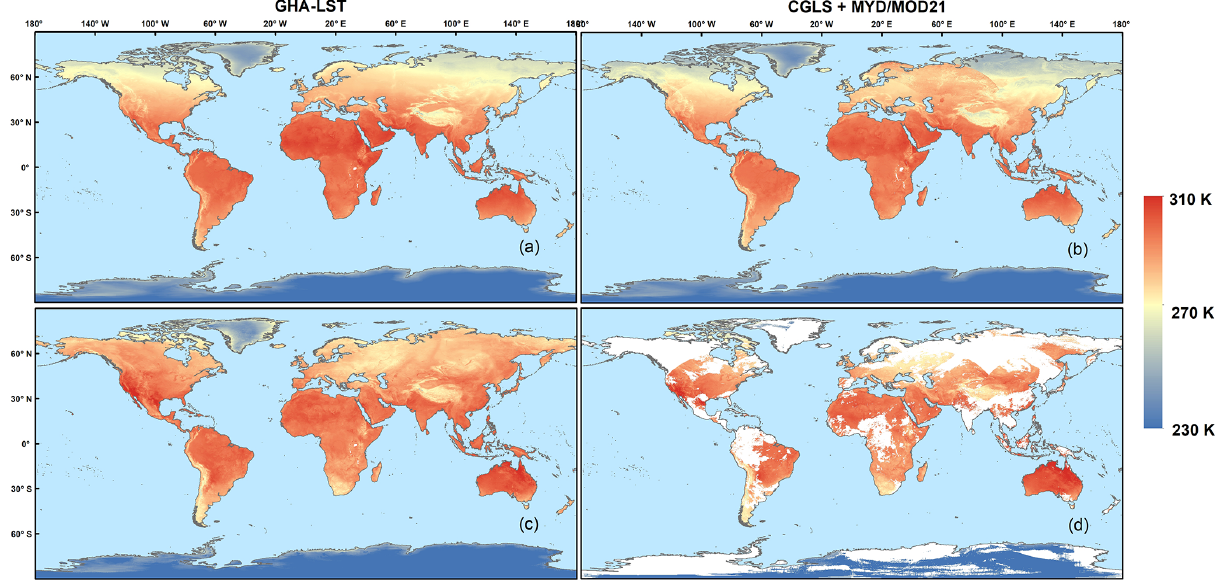
Figure 8. Global LST maps of the (a) GHA-LST annual mean in 2021 and the (b) CGLS, MYD, and MOD21 annual mean in 2021 as well as the corresponding hourly LST maps at 02:00UTC on 7 September 2021 for (c) GHA-LST and (d) CGLS, MYD, and MOD21. The abbreviations used in the figure are as follows: GHA-LST is the global hourly, 5km, all-sky land surface temperature, and CGLS is the Copernicus Global Land